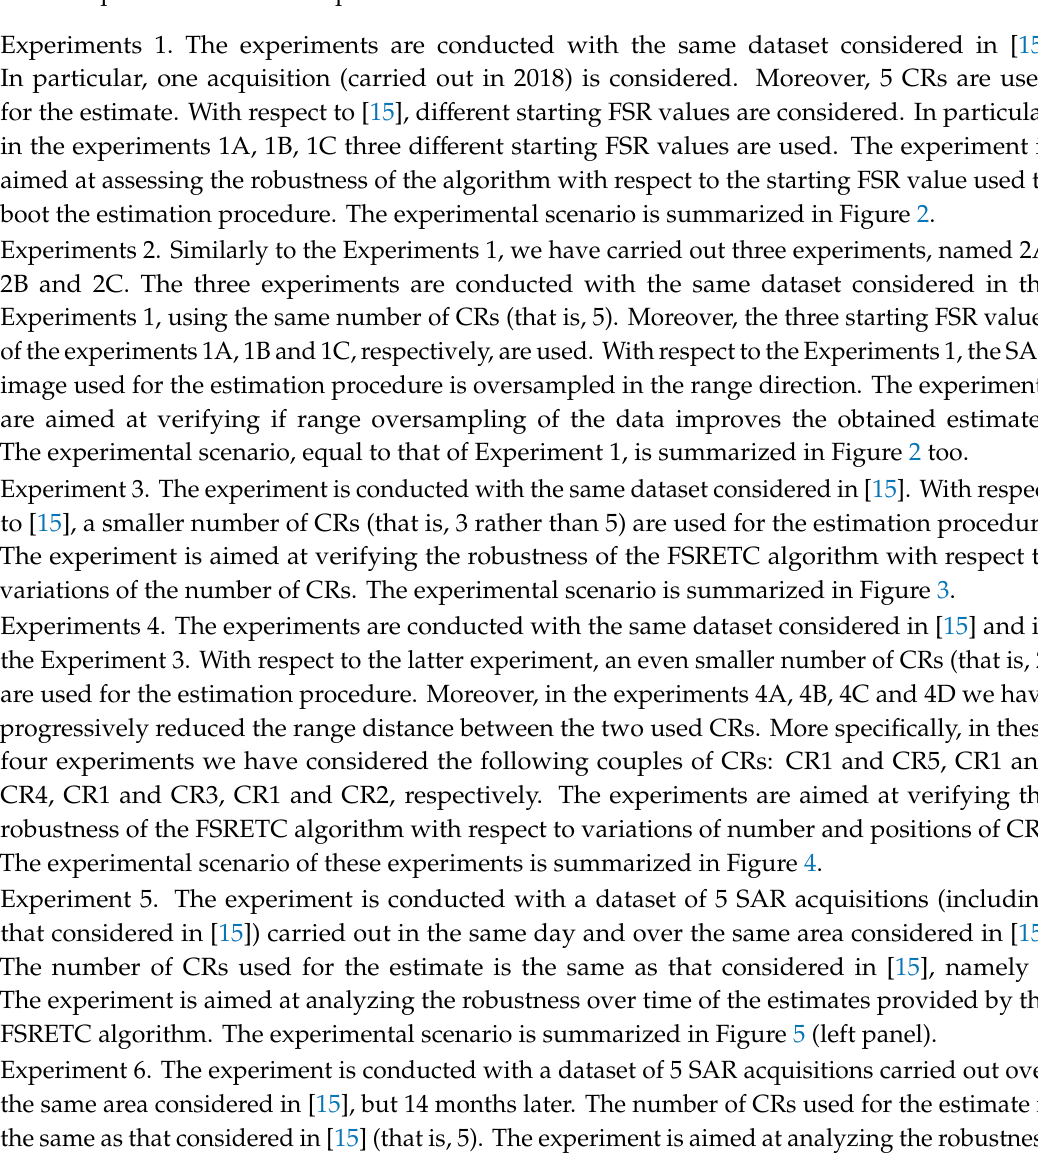
Figure 1. Multi-look amplitude SAR image (in geographic grid) patch of the entire acquired strip. The green circles indicate the CRs’ positions. Left: relevant to the 2018 campaign. Right: relevant to the 2019 campaign. Table 1. AXIS system parameters.